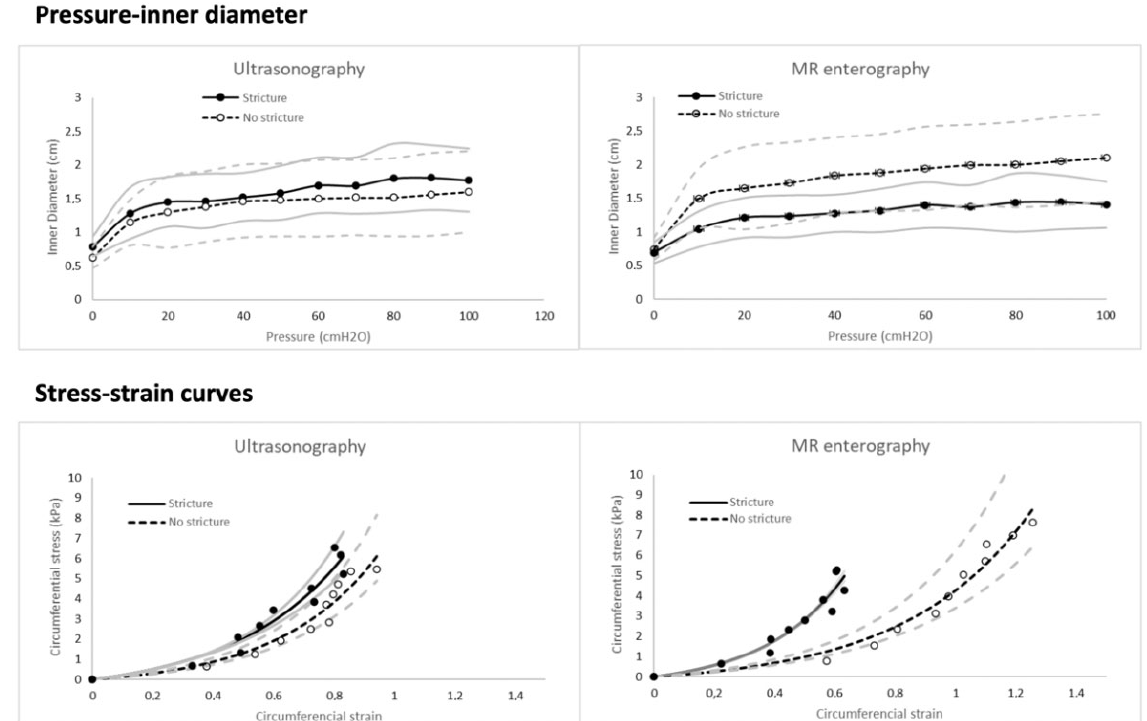
Figure 3. The averaged inner diameter-pressure curves ( top ) and averaged circumferential stress-strain curves ( bottom ) for strictures preoperatively assessed as “stricture” (solid lines) or “non-stricture” (dashed lines) with ultrasonography ( left ) and MR enterography ( right ). Dots are averaged data, and solid lines are curve-fitted. Grey lines are confidence intervals.